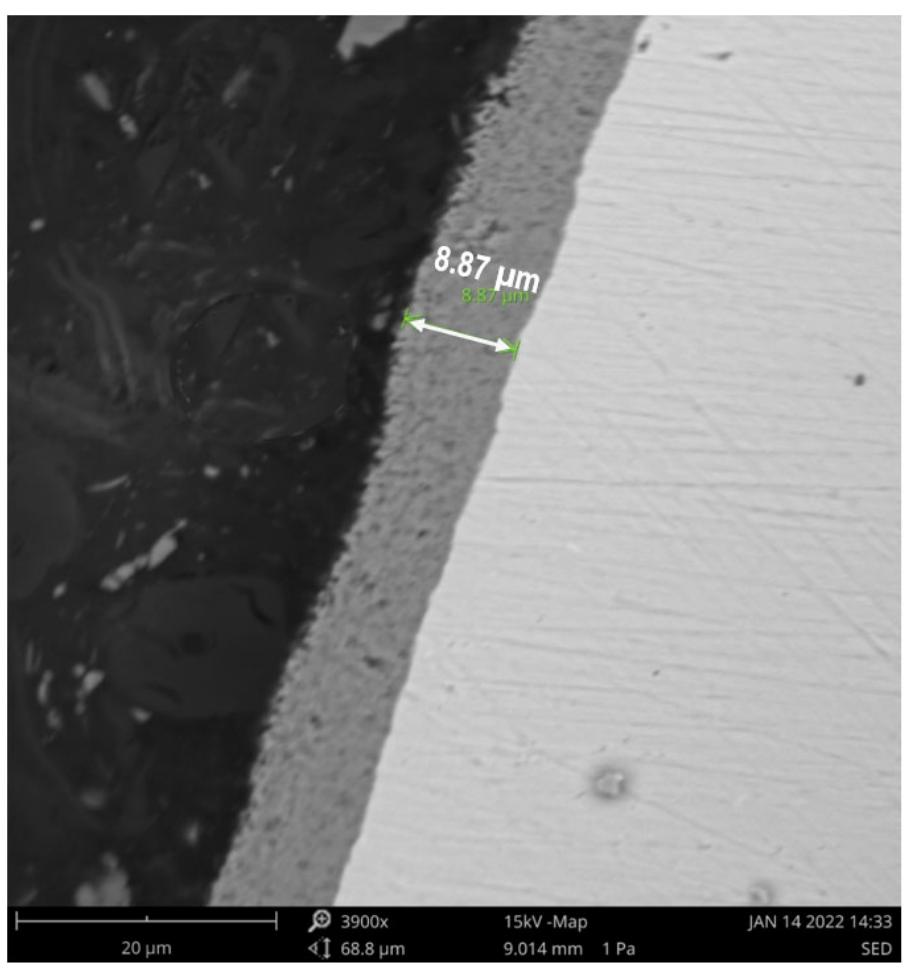
Figure 3. Scanning electron microscope (SEM) image of porous layer sample, cross ‐ section view.